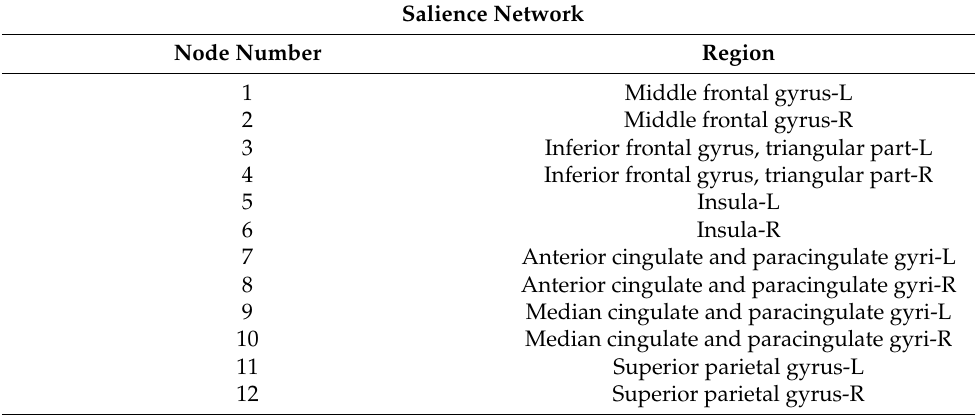
Table 3. ROIs of the SAN corresponding to the activity pattern in Figure 2a,b.